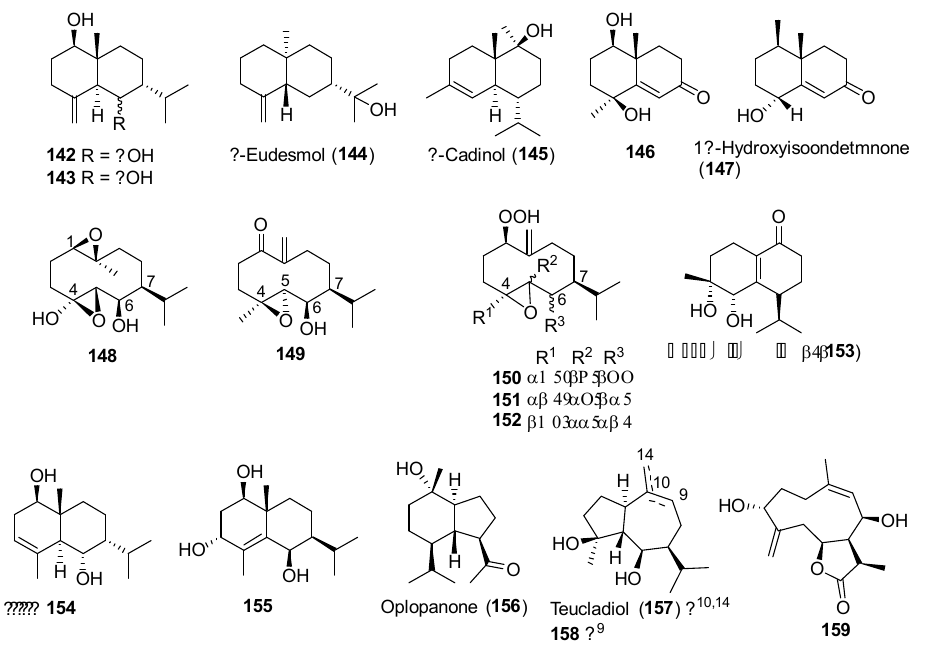
Figure 10. Representative sesquiterpenoids isolated from Teucrium polium.